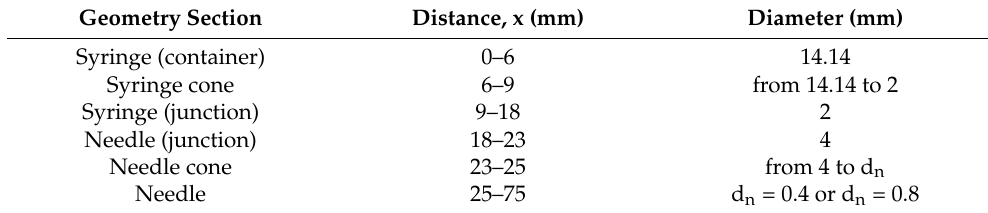
Figure 2. ( A ) Wet spinning syringe and needle geometry in the experiment. ( B ) The wedge geometry is designed using the internal dimensions of the experimental system. ( C ) Schematic of the wedge geometry and the mesh used in the CFD calculations. Table 1. Wedge geometry